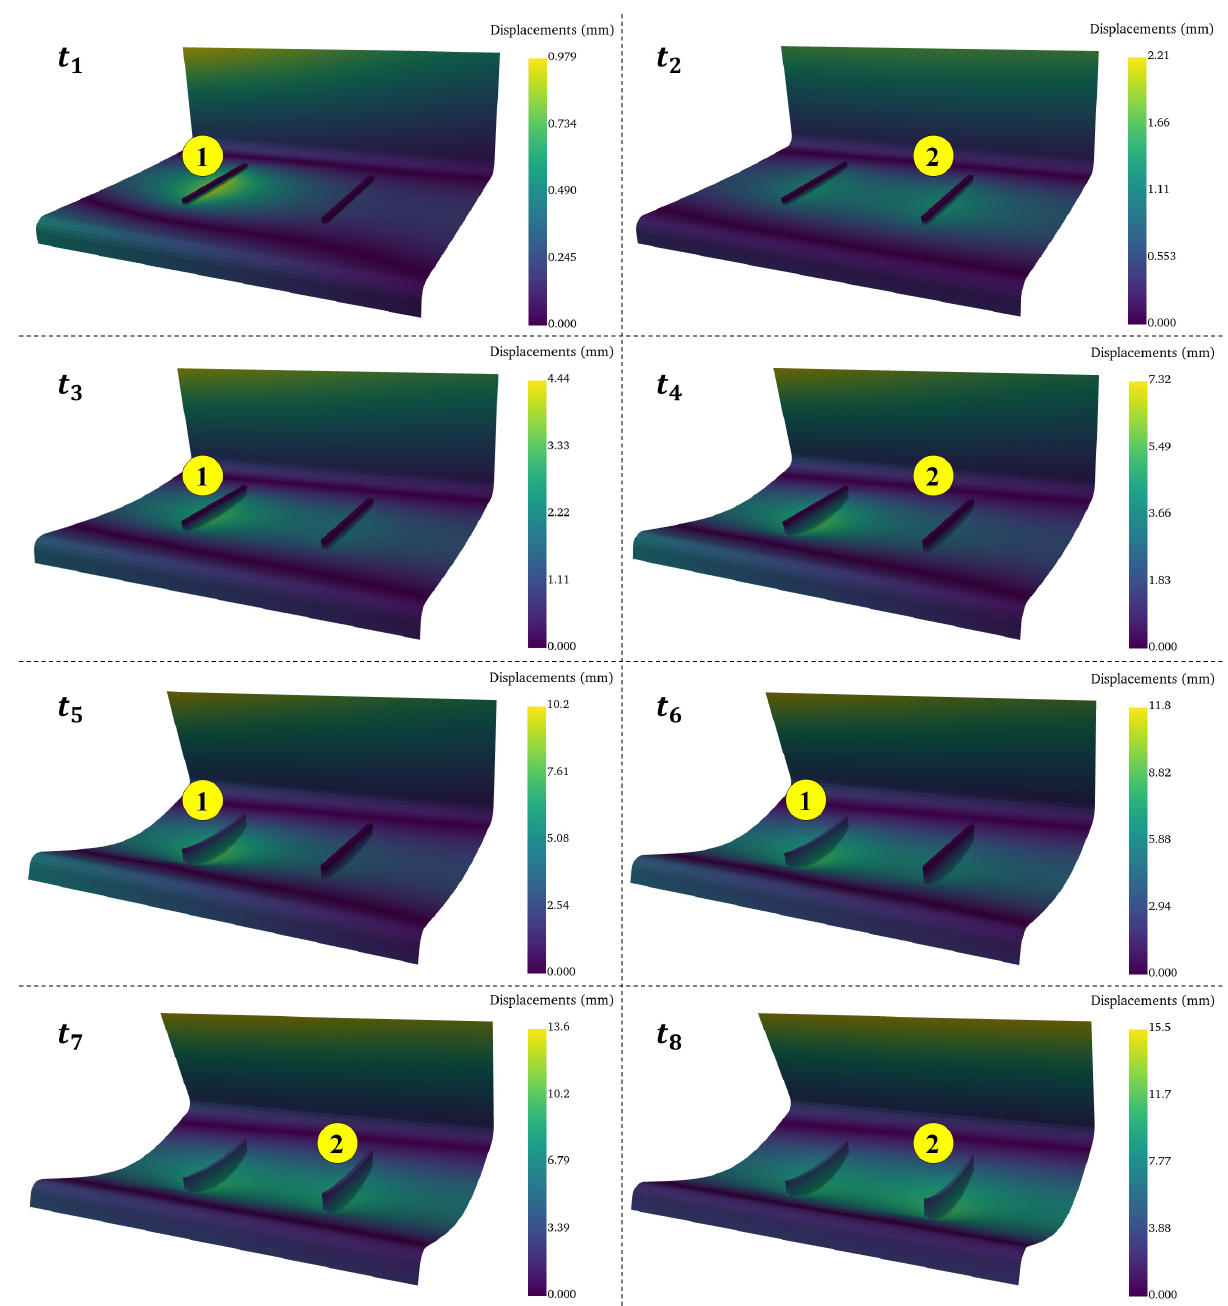
Figure 5. High-fidelity simulation of the sequence { 1,2,1,2,1,1,2,2 } (displacements × 3 for visualization). Both stiffeners are placed from the beginning on the sheet, and each layer of them is sequentially mechanically